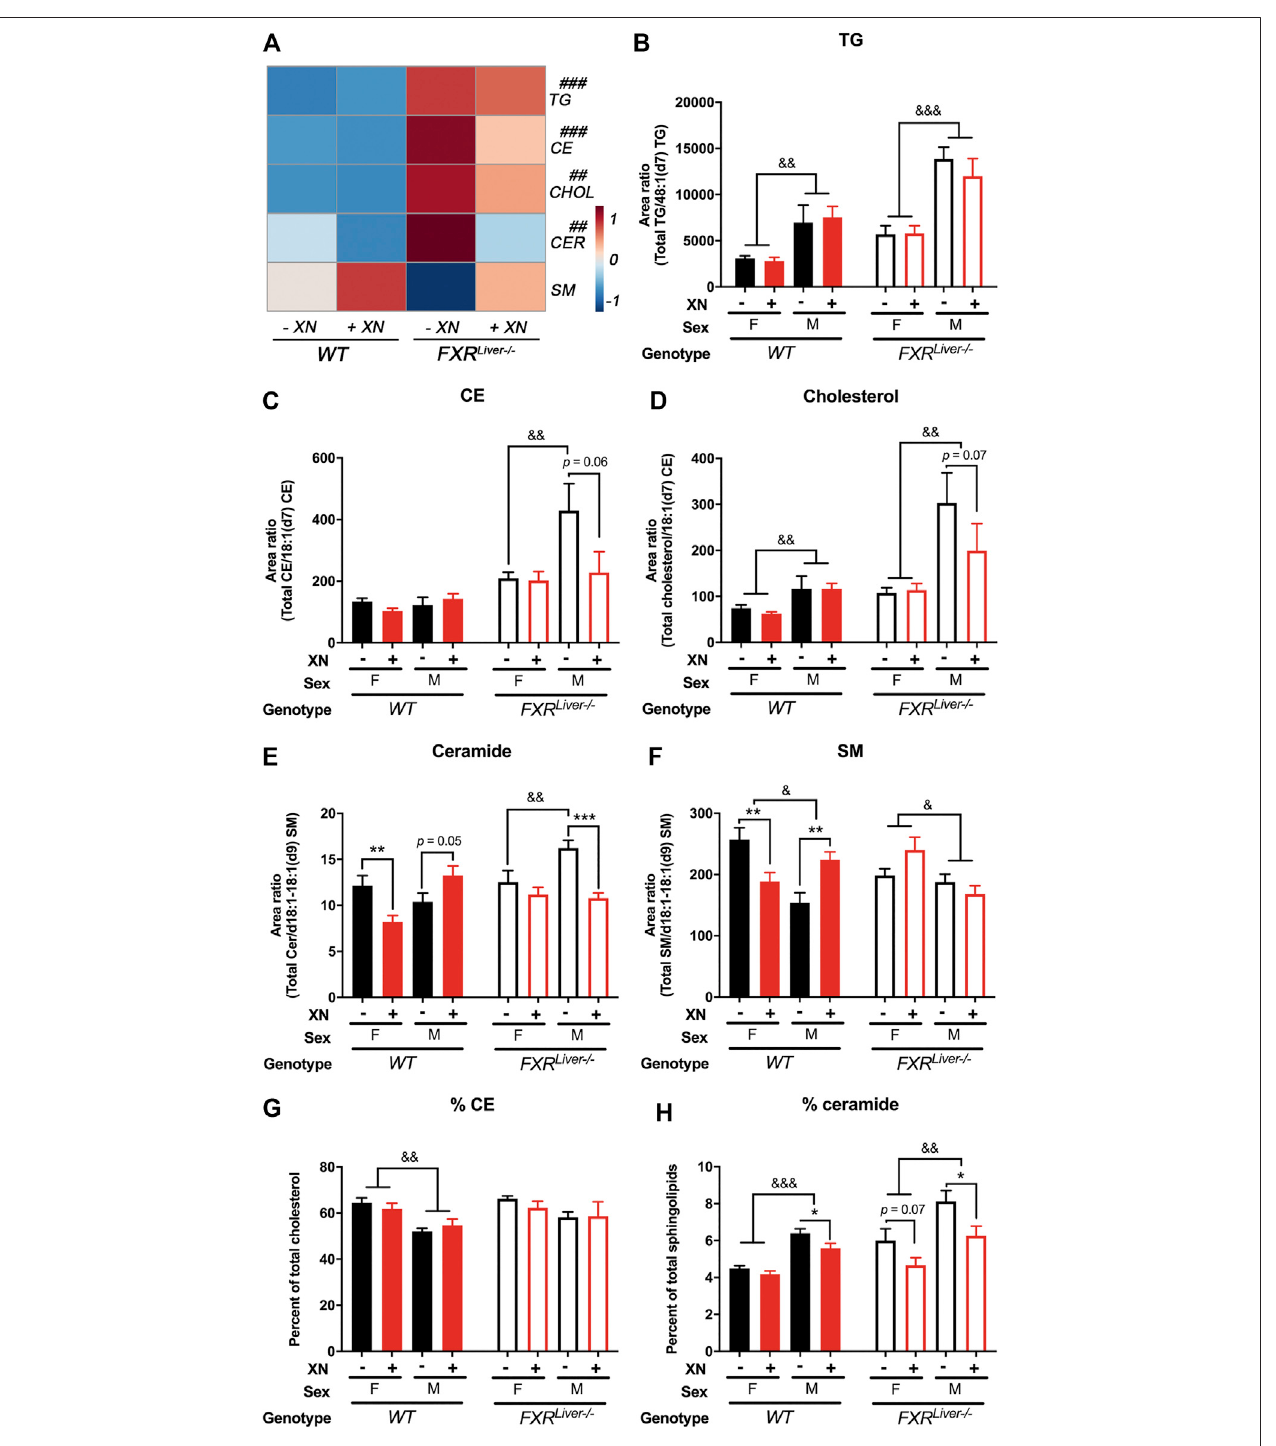
FIGURE 2 | XN prevents HFD-induced ceramide accumulation (A) Heatmap of hepatic triglycerides (TG), cholesterol esters (CE), free cholesterol (CHOL), ceramides (CER) and sphingomyelins (SM) in HFD-fed WT and FXR Liver − / − mice untreated or treated with XN. Total relative abundance of (B) TG (C) CE (D) free cholesterol (E) ceramide and (F) SM in the liver of WT and FXR Liver − / − mice untreated or treated with XN. Proportion of (G) CE and (H) ceramide in the liver of WT and FXR Liver − / − miceuntreatedortreatedwithXN.Valuesaremean ± SEM(n (cid:2) 7 – 10pergroup).* p < 0.05,** p < 0.01,*** p < 0.001foreffectofXNtreatment;# p < 0.05, ## p < 0.01, ### p < 0.001 for genotype comparison; & p < 0.05, & p < 0.01, & p < 0.001 for gender comparison.